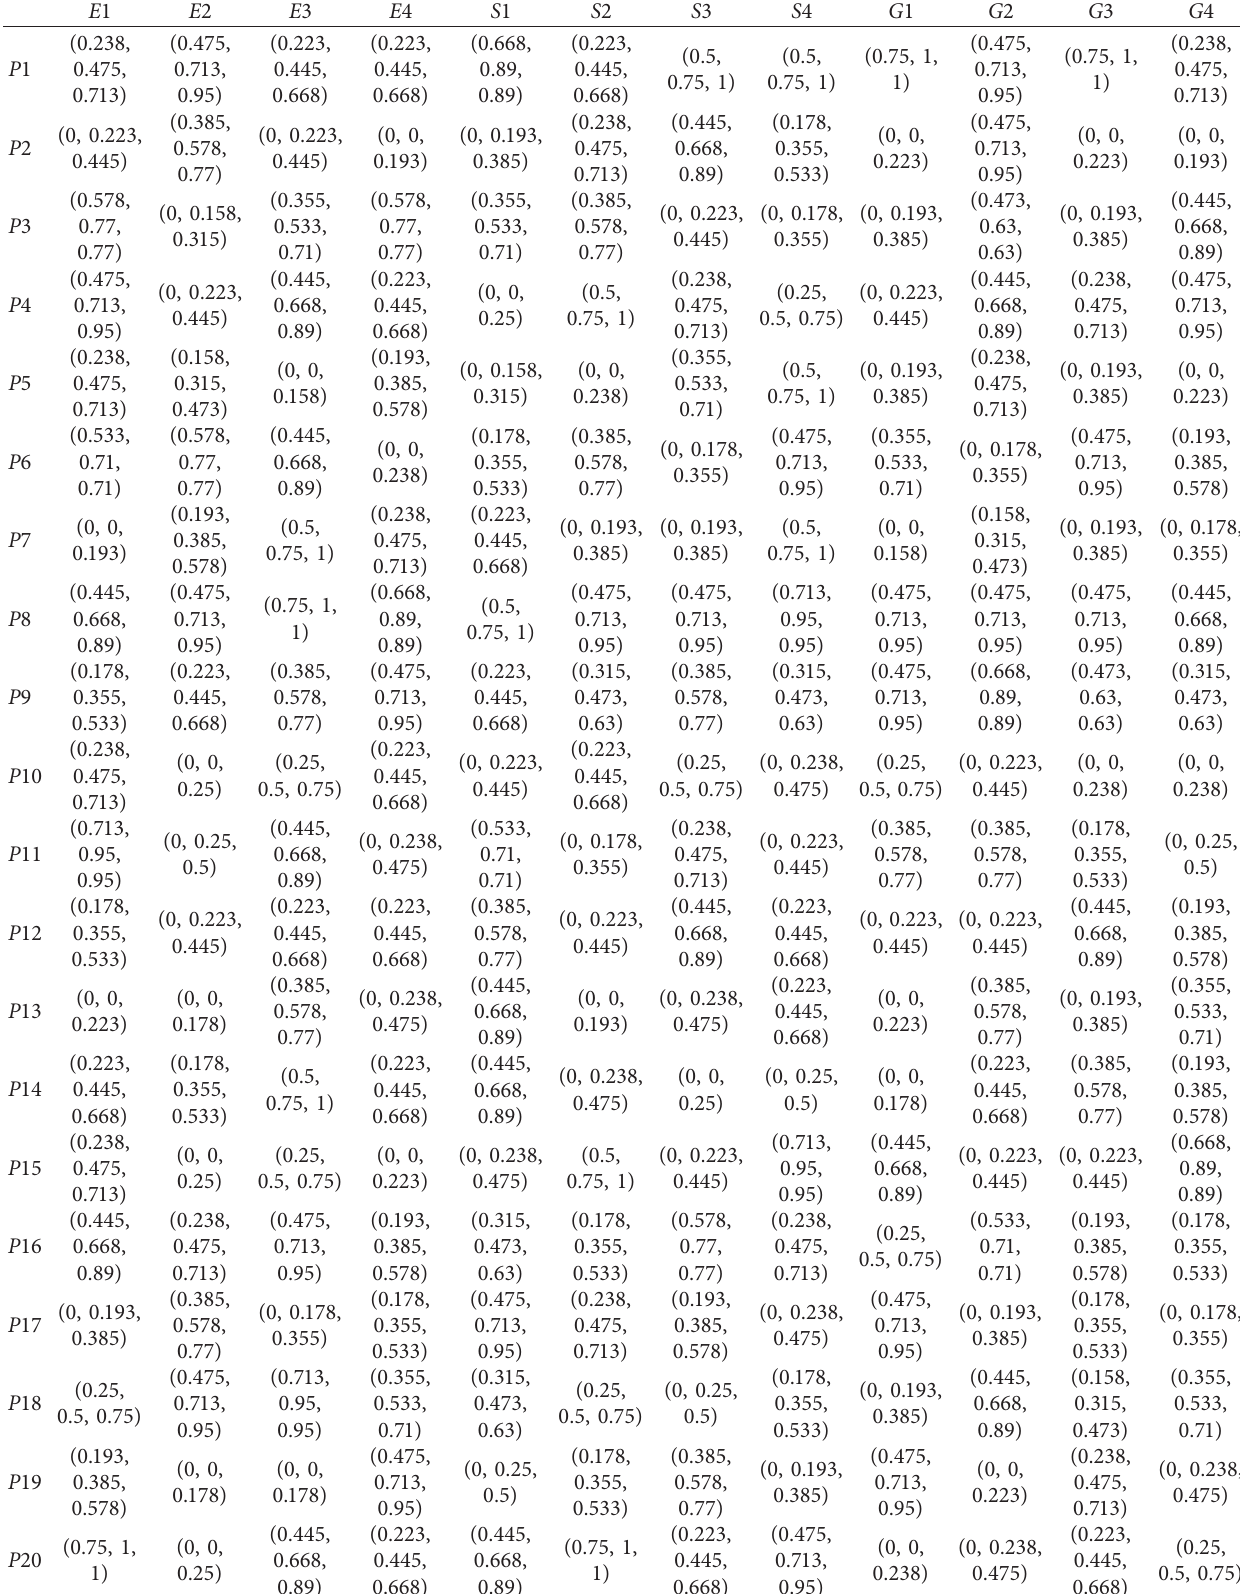
Table 47: Quantified probabilistic linguistic scoring spectrum for sustainability criteria for proposed